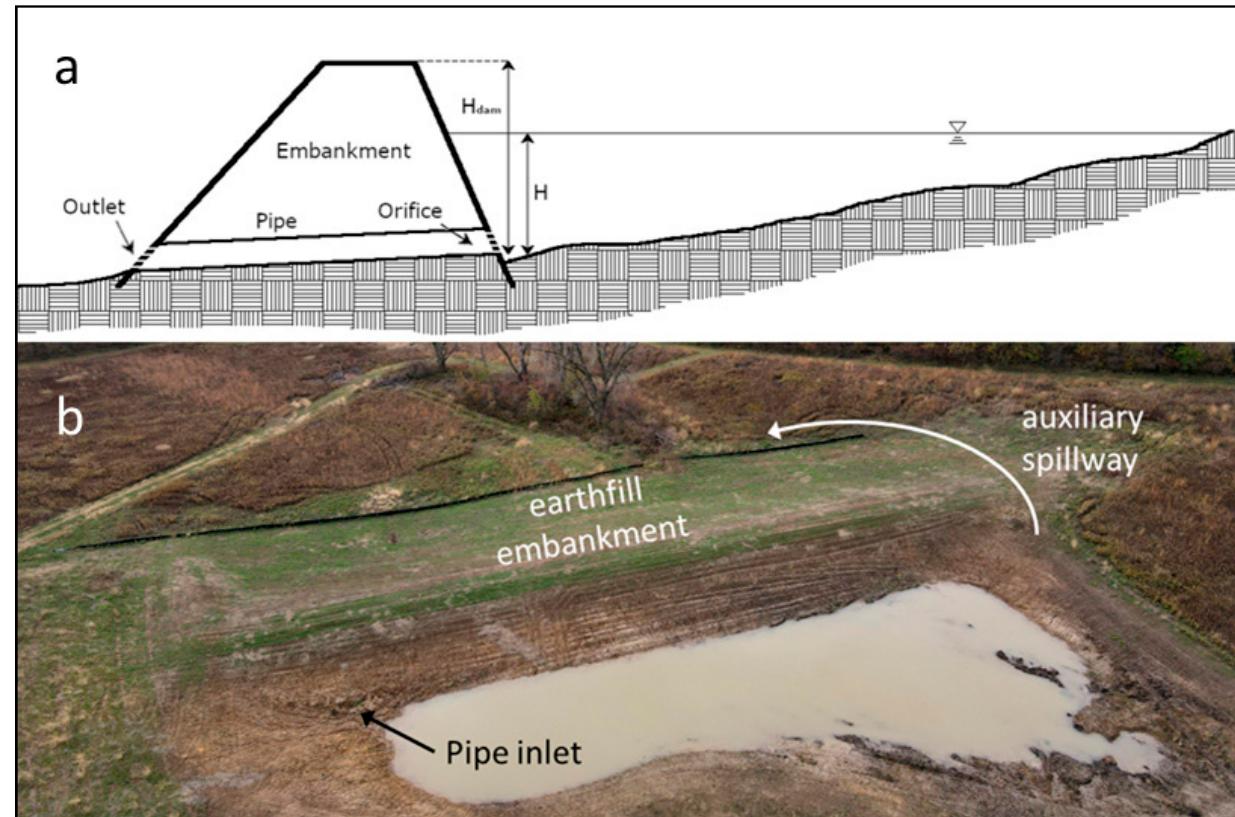
Figure 3. Examples of inline reservoir used as runoff attenuating feature. ( a ) Simplified cross-section; ( b ) aerial view of a pond on Clear Creek, IA (courtesy of Iowa Flood Center).